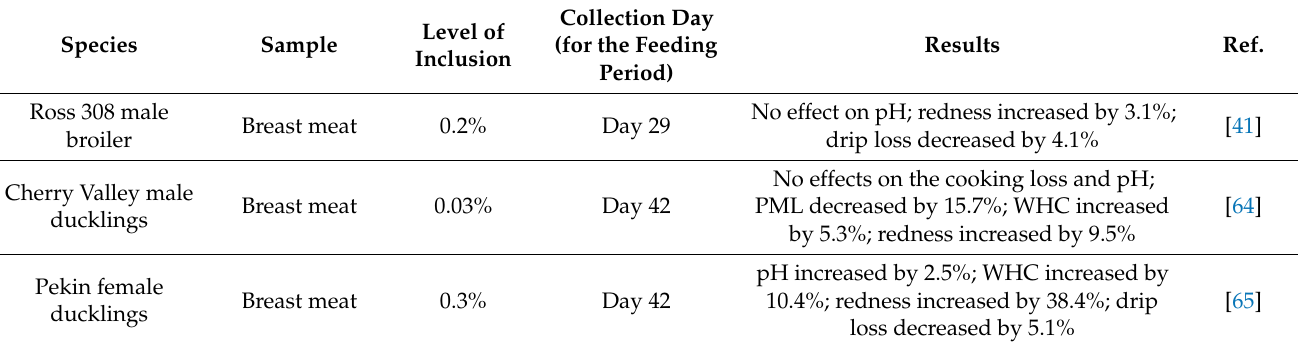
Table 4. MSM inclusion in the diets and effects on meat quality in comparison with